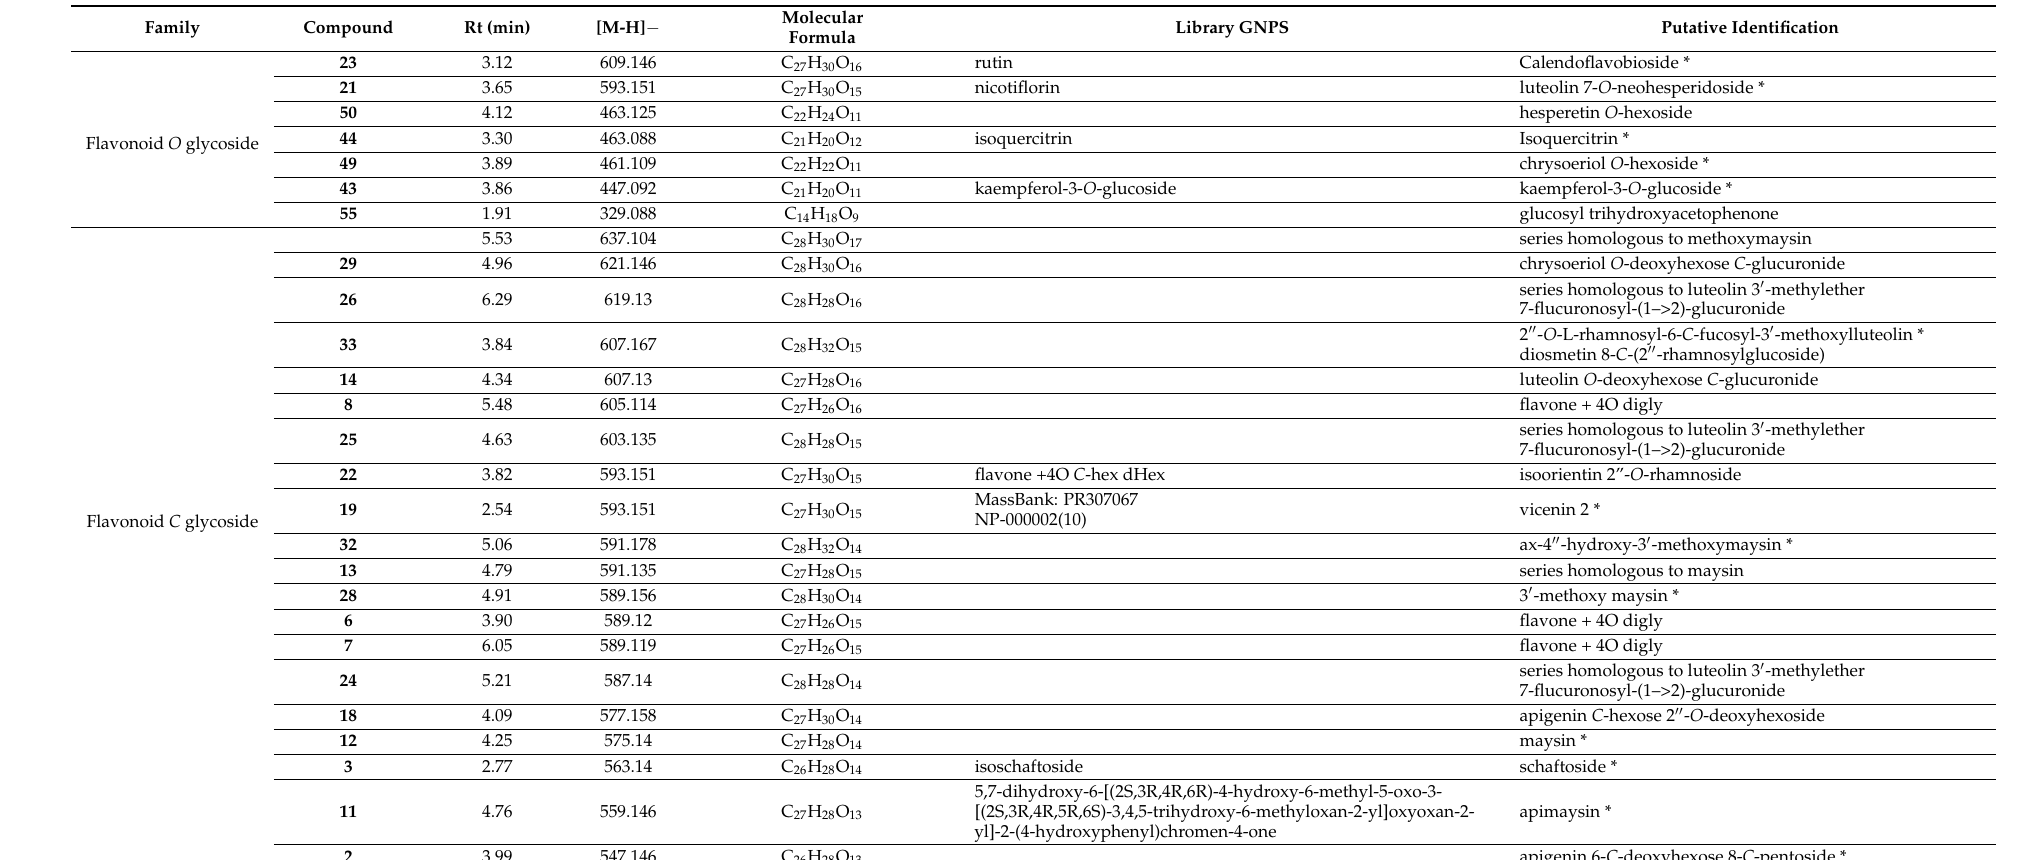
Table 4. Synthesis of molecules identified in the corn silk extract